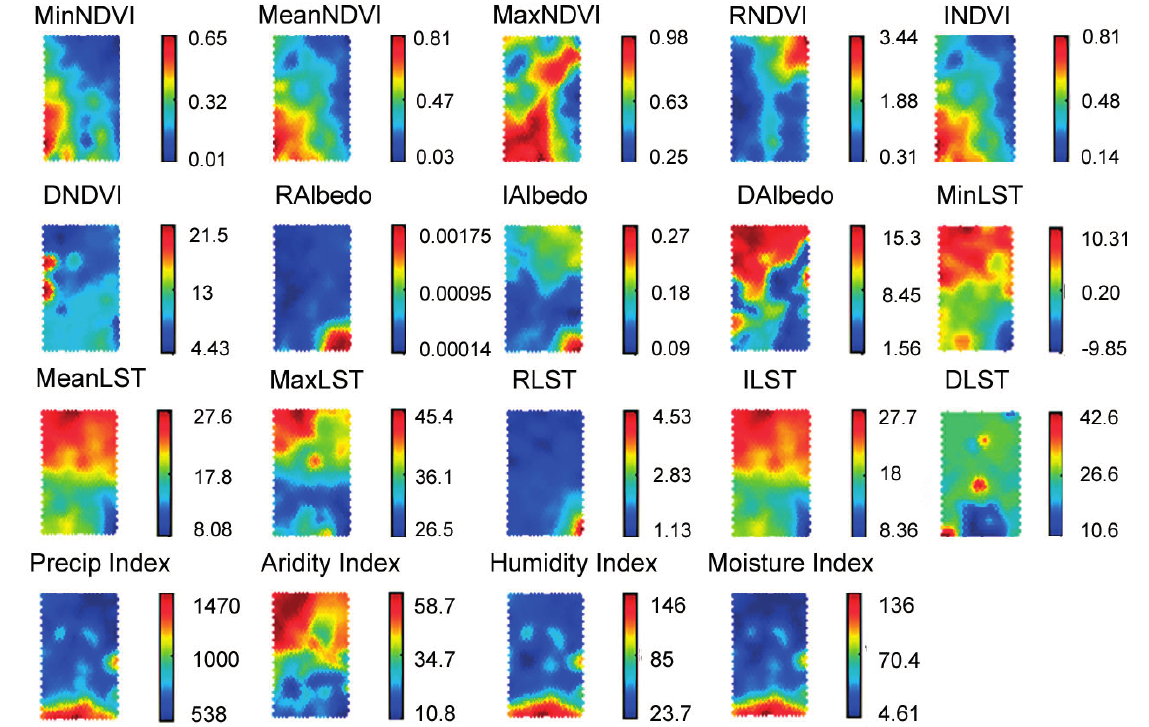
Figure 5. Visualization of the two-plane components of the Self-Organizing Map (SOM) trained from time series of NDVI, Albedo, LST and climatic data of